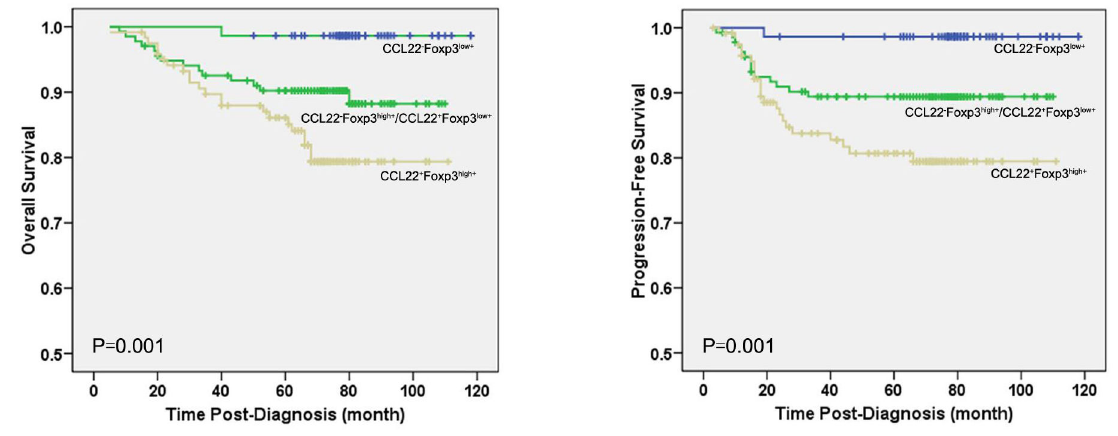
Expression of both CCL22 and Foxp3 + Tregs infiltration in the tumor bed was associated with BC prognosis. Kaplan-Meier curves are shown for overall survival (OS) (A) and progression-free survival (PFS) (B) was stratified by expressions of two factors to divide the patients into three subsets, CCL22 - Foxp3 low+ group, CCL22 - Foxp3 high+ /CCL22 + Foxp3 low+ group, and CCL22 + Foxp3 high+ group. The CCL22 + Foxp3 high+ group was associated with both shorter OS (P=0.001) and PFS (P=0.001) than CCL22 - Foxp3 high+ /CCL22 + Foxp3 low+ group, and CCL22 - Foxp3 low+ group. doi: